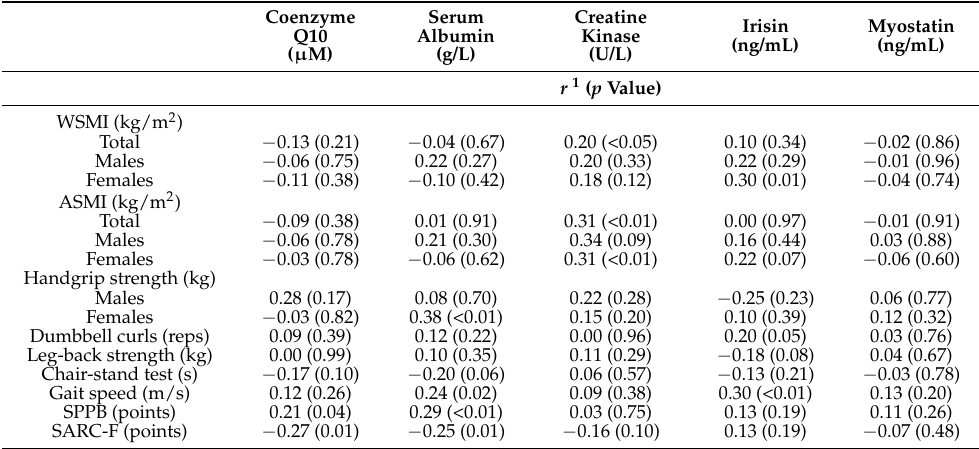
Table 2. Correlations between coenzyme Q10 and the skeletal muscle protein biomarkers and muscle